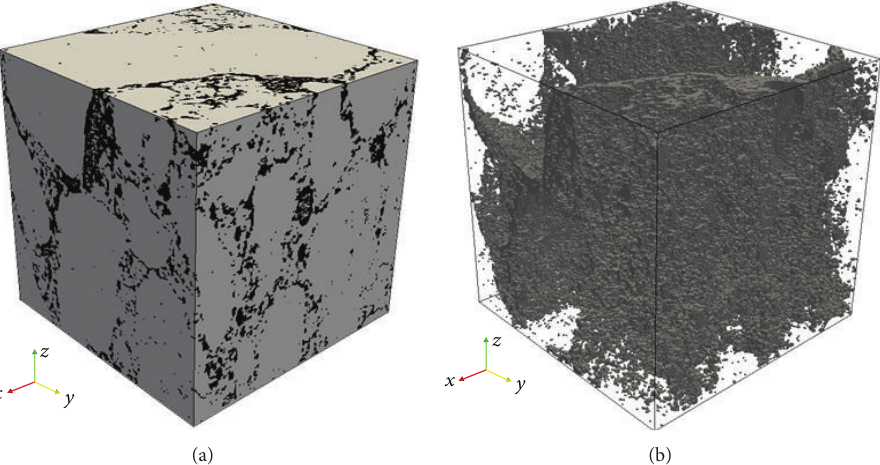
Figure 7: 3D binary image of insulating concrete specimen (void ratio = 10.93%): (a) whole binary image and (b) void distribution within